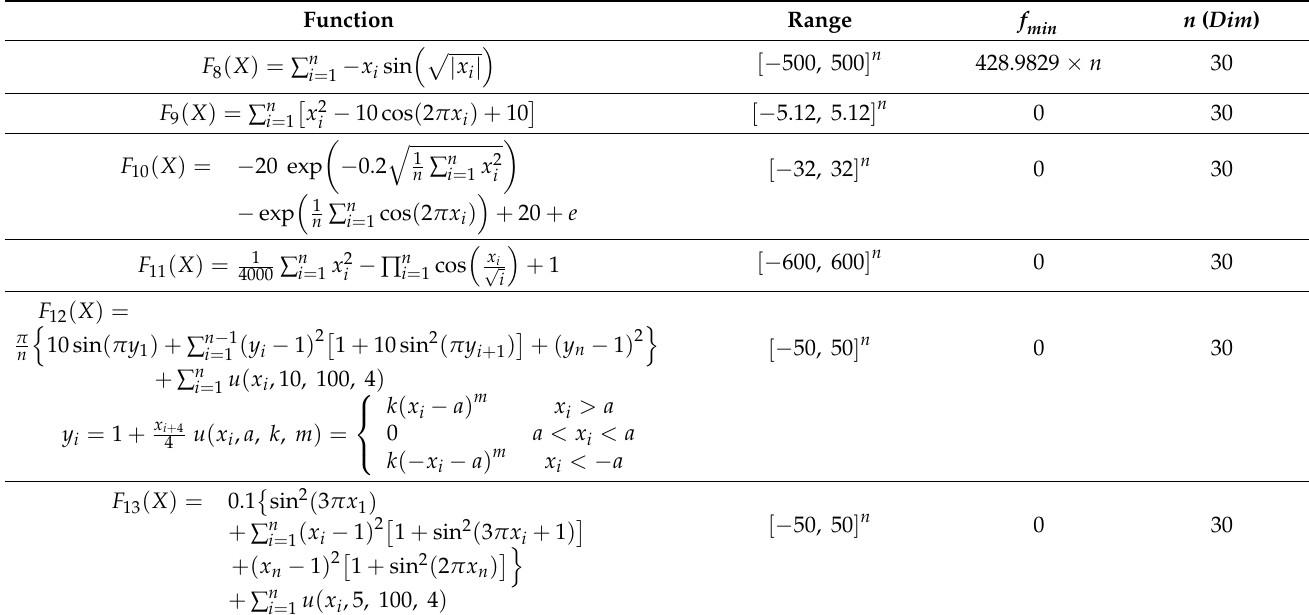
Table 3. Description of multimodal benchmark